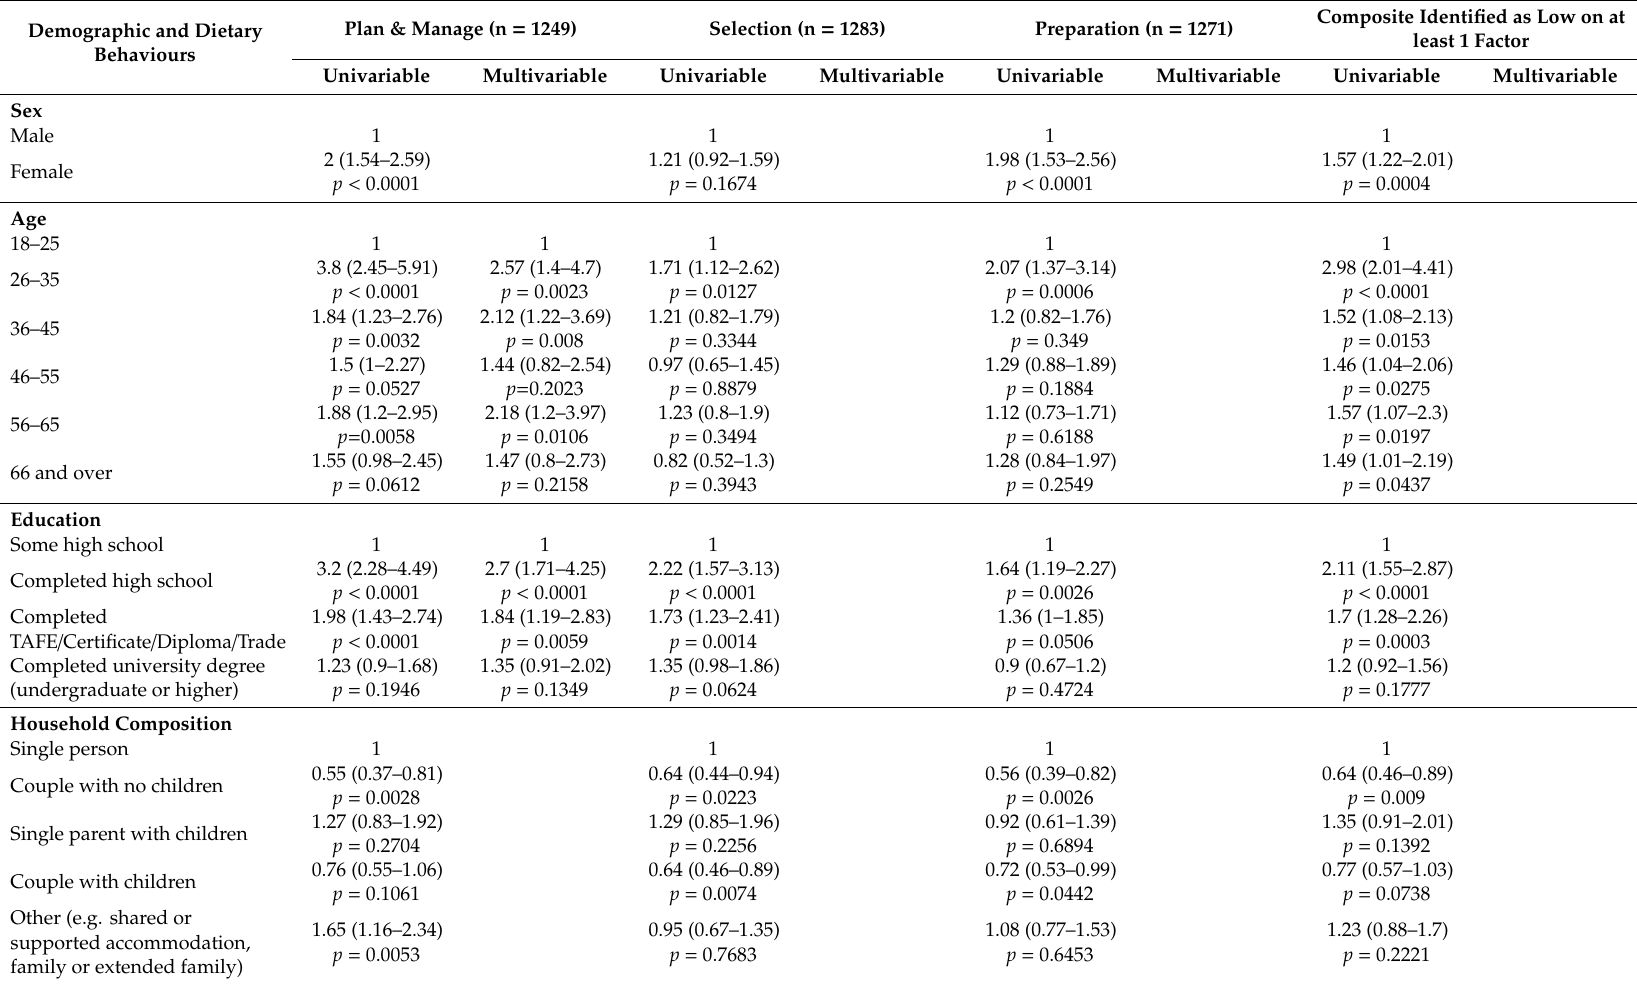
Table 4. Demographic, dietary intake and food-related skill variables and their association with low food literacy behaviours. Numerical values denote the odds ratio with 95% confidence interval in brackets followed by the p